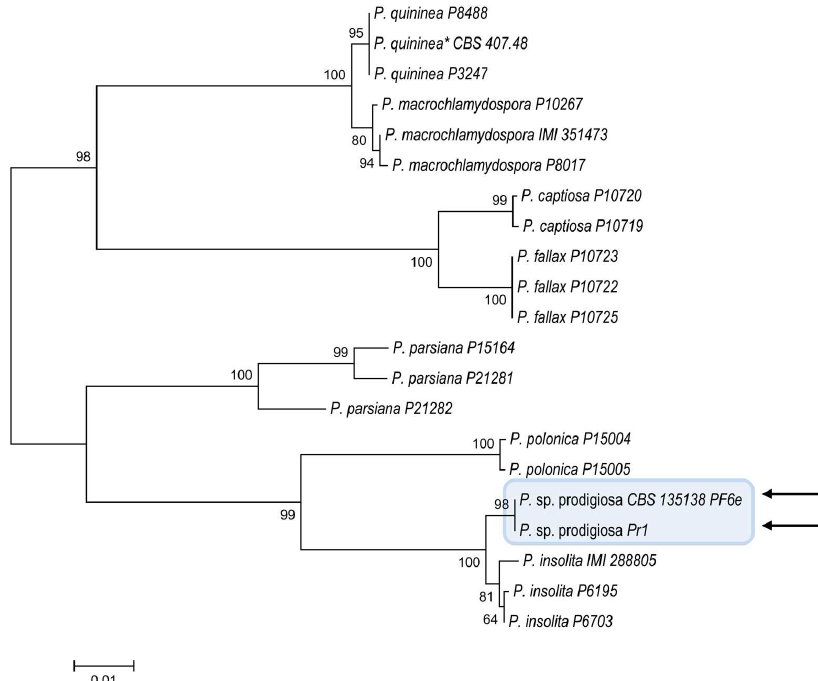
Fig 6. Molecular phylogenetic analysis of the combined data set ITS and COI among isolates PF6e and Pr1 of P . sp. prodigiosa (indicated by arrows) within Phytophthora major Clade 9 by Maximum Likelihood method, based on the Tamura-Nei model. The percentage of trees in which the associated taxa clusteredtogether is shown next to the branches. Initial trees for the heuristic search were obtained by applyingthe Neighbor-Joiningmethod to a matrix of pairwisedistancesestimated using the Maximum Composite Likelihood(MCL) approach.The tree was drawn to scale, with branch lengthsmeasuredin the numberof substitutionsper site. Bootstrap values were obtainedfrom 1000replications.Asterisk ( * ) indicates the ex-type